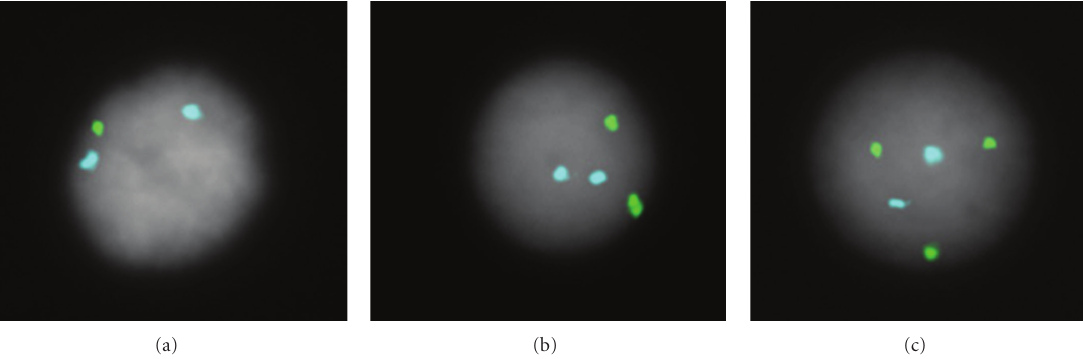
Figure 2: FISH analysis on interphase nuclei. FISH was performed using alpha satellite probes of X (green) and 18 (aqua) chromosomes. The images show the three di ff erent categories of signals detected: (a) X monosomy (two 18 signals and one X signal); (b) X disomy and (c) X trisomy.